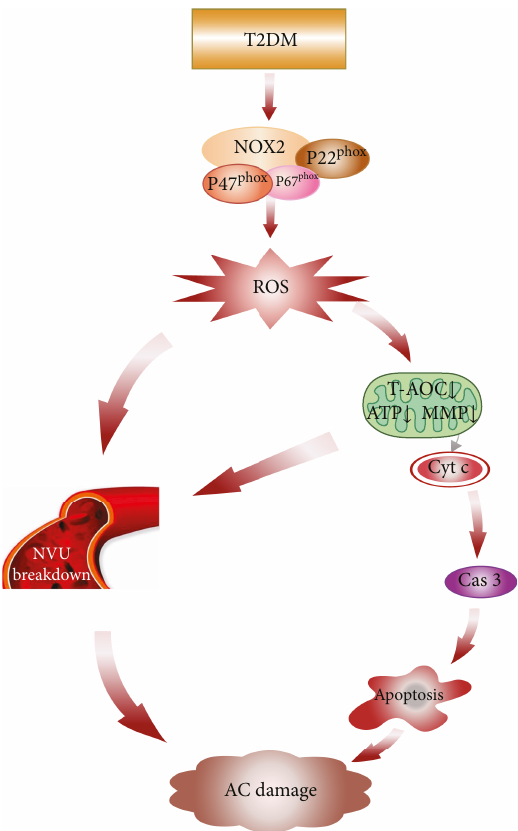
Figure 8: Schematic diagram of auditory cortex damage induced by T2DM. T2DM induces NOX2 and its corresponding subunits form an active NOX2 complex to promote ROS generation. ROS overproduction induces NVU breakdown and mitochondrial oxidative damage including T-AOC decline and mitochondrial dysfunction (ATP ↓ and MMP ↓ ). The impaired mitochondria release Cyt c from the mitochondrial intermembrane space into the cytoplasm and induced apoptosis via the caspase 3-dependent pathway. Meanwhile, the mitochondrial dysfunction also triggers NUV breakdown. Finally, the neuronal apoptosis and NUV breakdown may lead to AC damage. AC: auditory cortex; Cas 3: caspase 3; Cyt c: cytochrome c; MMP: mitochondrial membrane potential; NOX2: NADPH oxidase 2; NVU: neurovascular unit; ROS: reactive oxygen species; T2DM: type 2 diabetes mellitus; T- AOC: total antioxidant